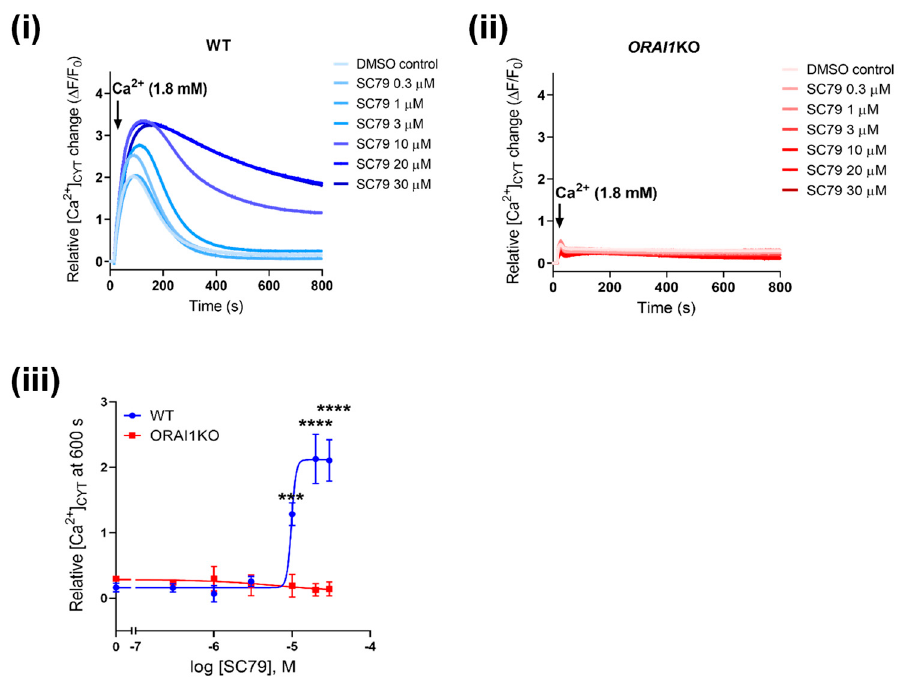
Figure 5. SC79-mediated Ca 2+ influx is abolished in ORAI1KO-GCaMP6m-MDA-MB-231 cells. Traces show Ca 2+ influx as a result of SC79 treatment (1 h) in (i) WT and (ii) ORAI1 KO cells. (iii) Concentration-response curve compares the sustained increases in [Ca 2+ ]CYT at 600 s between WT and ORAI1 KO cells. Statistical analysis was done using a two-way ANOVA with a Bonferroni’s test. **** p < 0.0001, *** p < 0.001.